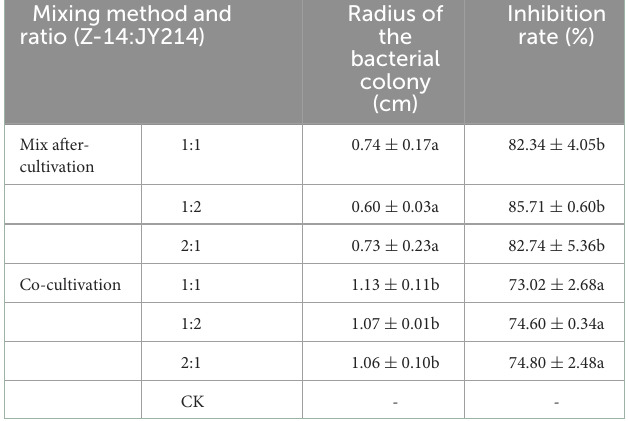
TABLE 3 Control effect of pesticide, Z-14, JY214, and their combinations on wheat take-all disease in the greenhouse experiments.